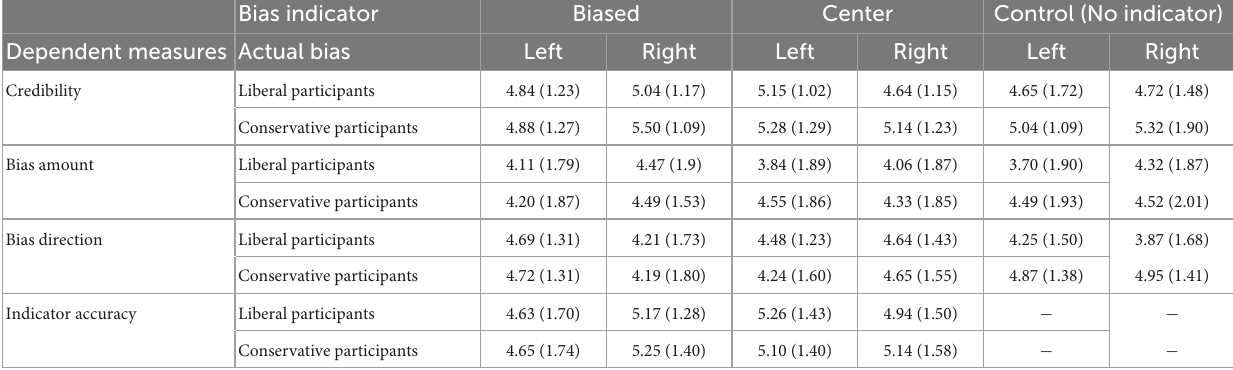
TABLE 2 Study 2 means and standard deviations of dependent measures across bias indicator and political conditions. Bias indicator Biased Center Control (No indicator) Dependent measures Actual bias Left Right Left Right Left